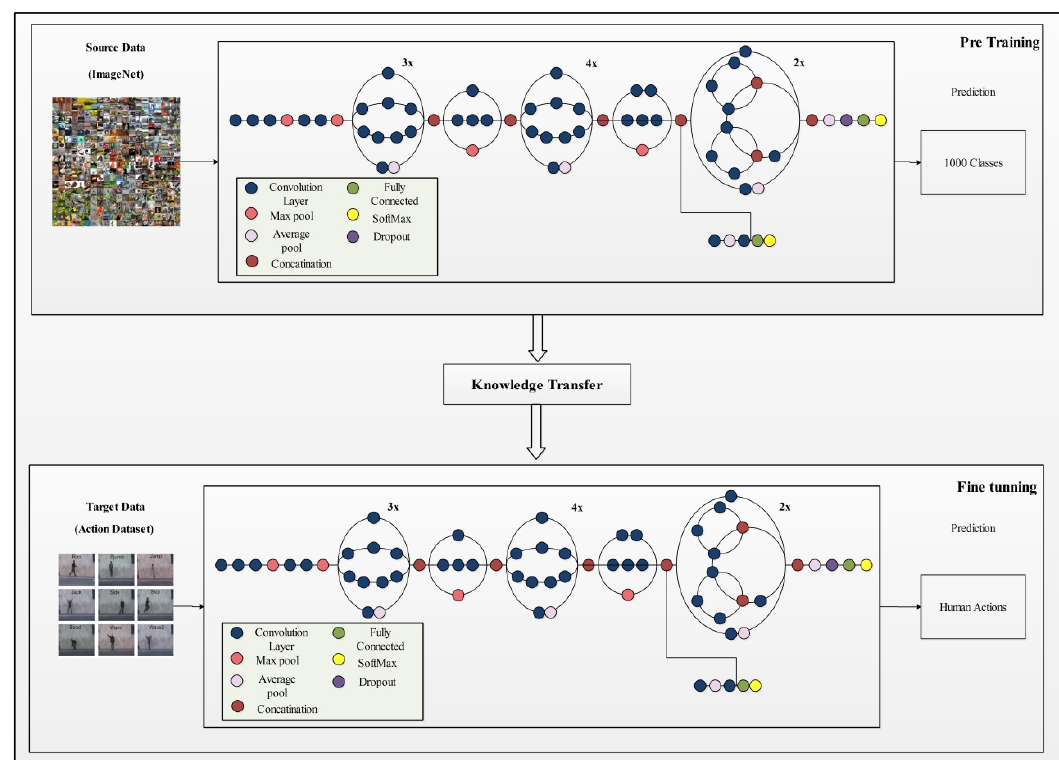
Figure 5. Target model (modified DenseNet201) for feature extraction.